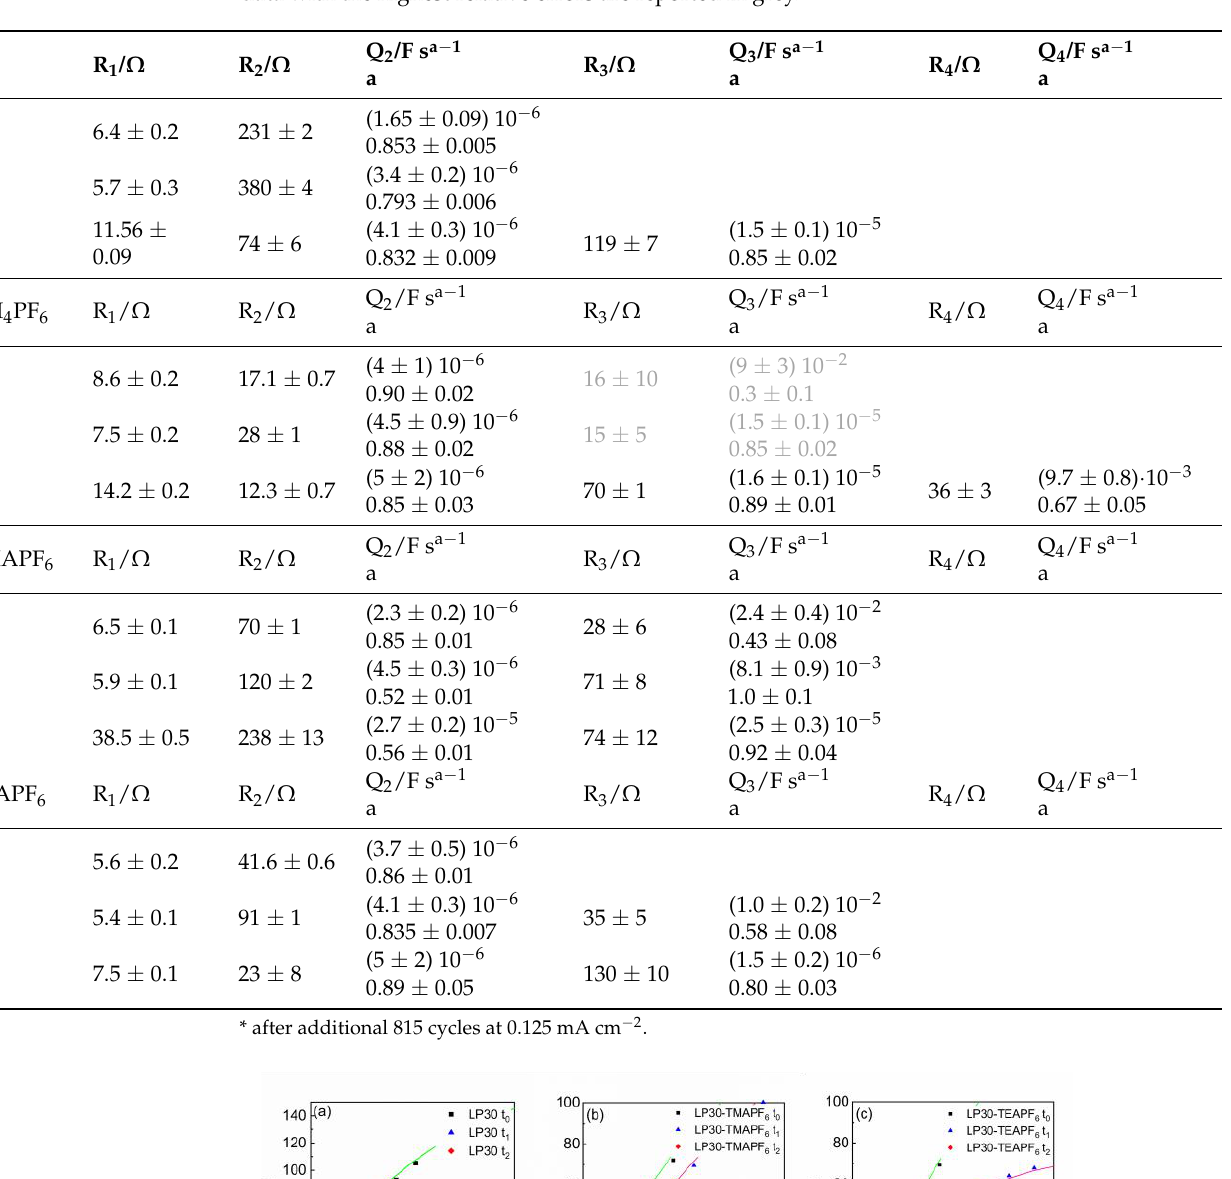
with PC-based solutions. t 0 = before test, t 1 = after 10 cycles at 0.125 mA cm −2 , t 2 = after additional 10